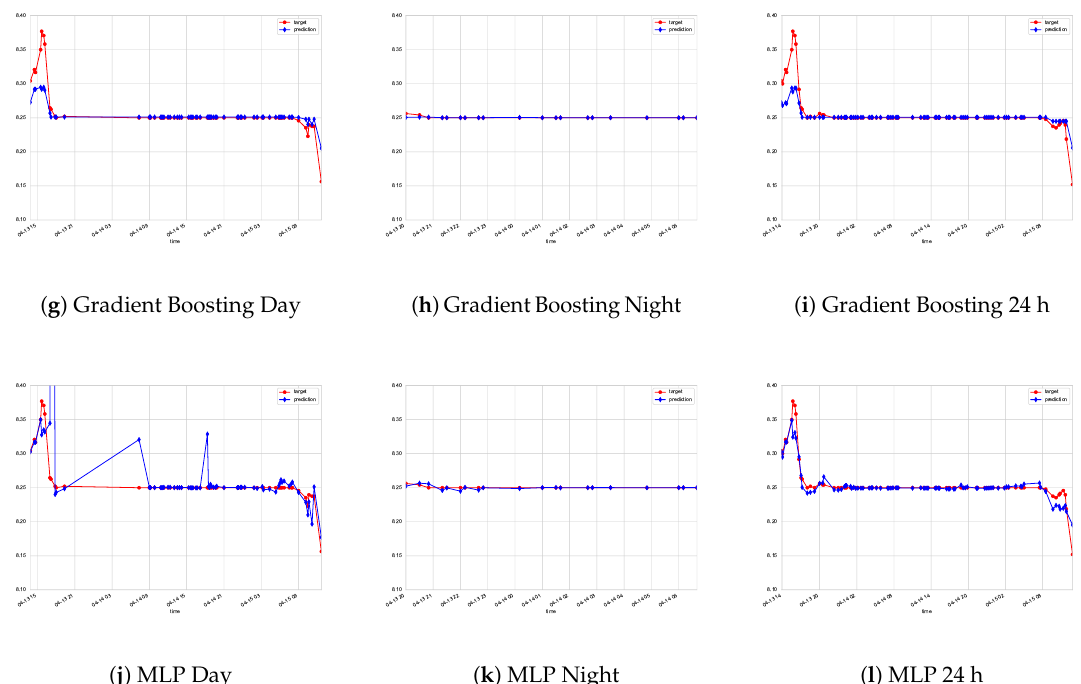
Figure 4. Actual data vs. predictions for Experiment A. ExtraTrees, random forest, gradient boosting, and MLP are considered for each model (day, night, and global model).